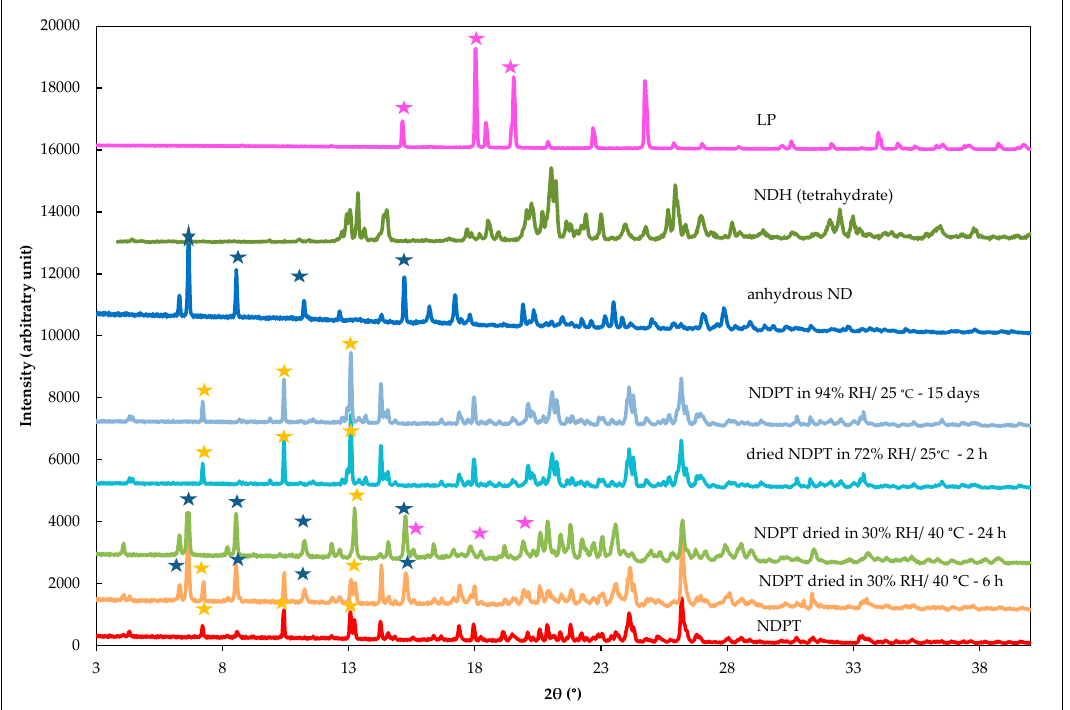
Figure 16. Diffractogram of NDPT fresh preparation after drying in 30% RH/40 °C for 6 h and 24 h, dried NDPT after 2 h restored in 72 ± 2% RH/25 ± 2 °C, and dried NDPT after restored in a 94% RH/25 ± 2 °C chamber for 15 days. Anhydrous ND, NDH (tetrahydrate), and LP diffractograms were depicted as the comparison. Assigned peaks represent ND (blue ticks), LP (purple ticks), and NDPT (yellow ticks).